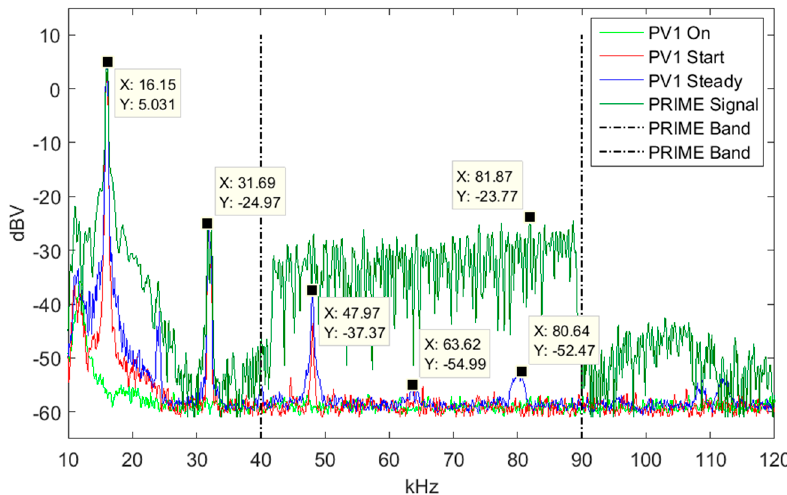
Figure 9. Spectrum recorded at the PV1 SM with the rest of devices disconnected.